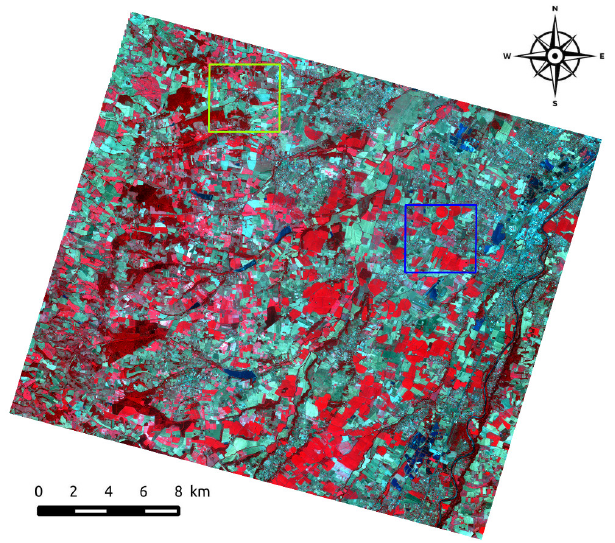
Figure 5. Formosat-2 image in false color (near infra-red, red, green) from 14 July 2006. Green and blue squares will be inspected visually in the experiments.